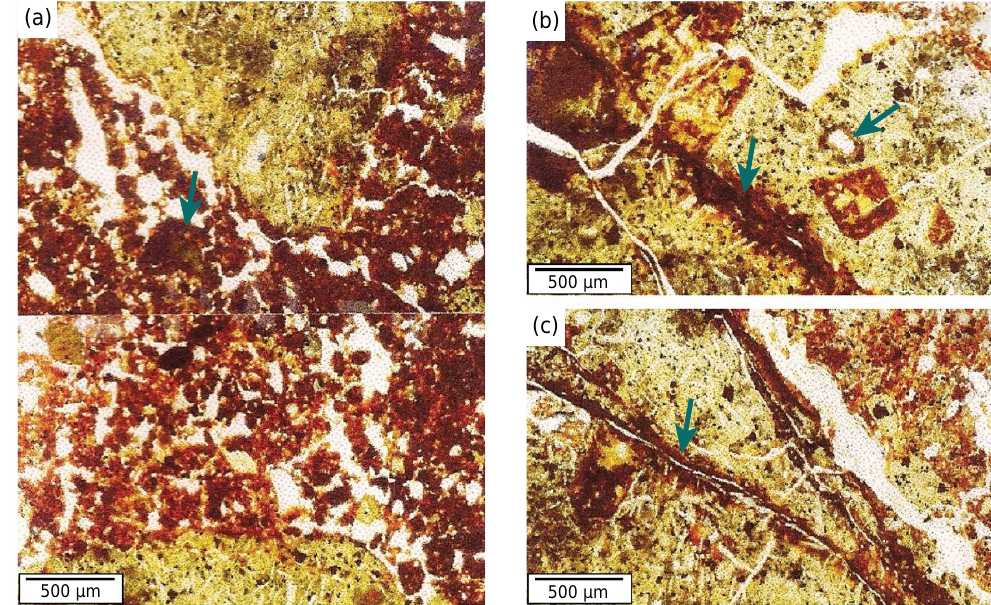
Figure 9. Photomicrographs of the Bi horizon in the P 6 - Eutric Chromic Petroplintic Leptic Cambisol (Clayic, Humic); Coromandel topolithosequence. Arrows indicate well-developed granular structure (a), and mangans and ferrans commonly found along pores, and coating grains (b and